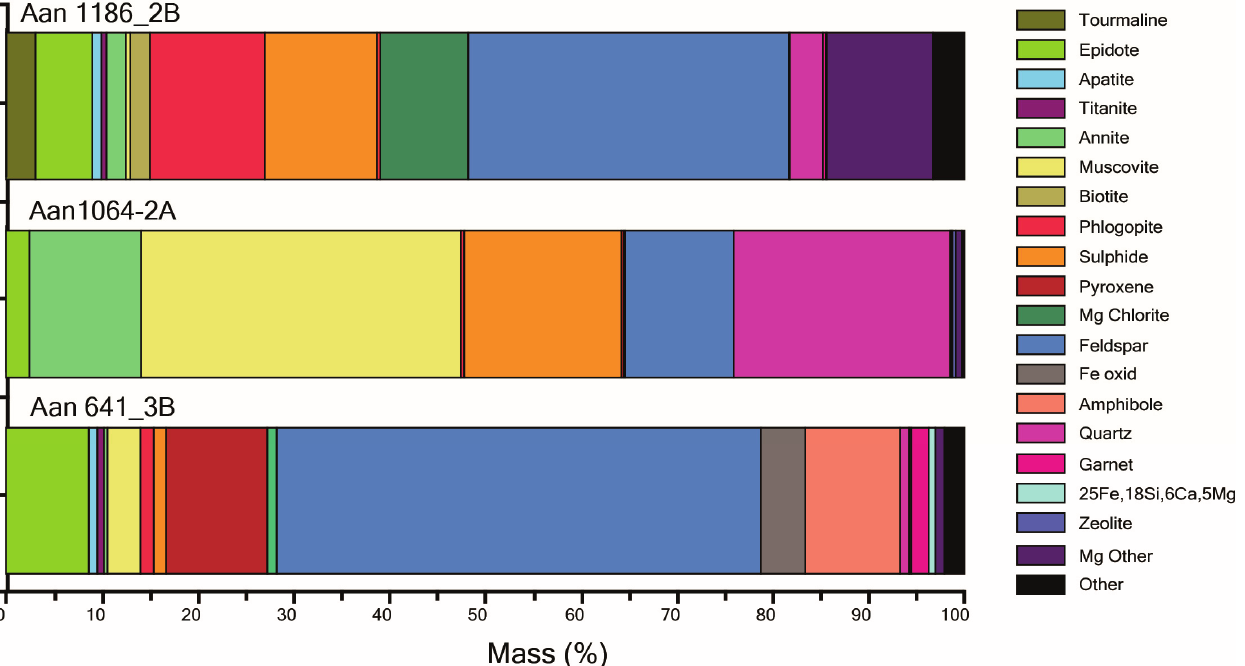
Figure 10. QEMSCAN diagrams showing the mineralogical composition for